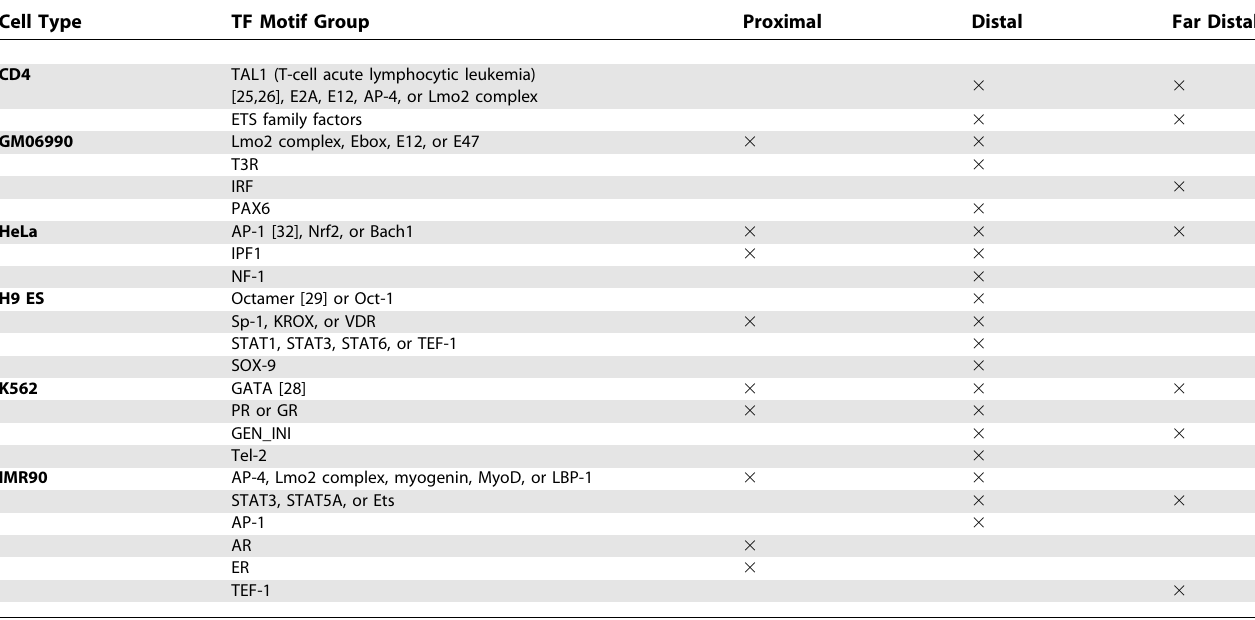
Table 2. Tissue-Specific DNaseI HS Sites Are Enriched in Motifs Indicative of the Corresponding Cell Types Cell